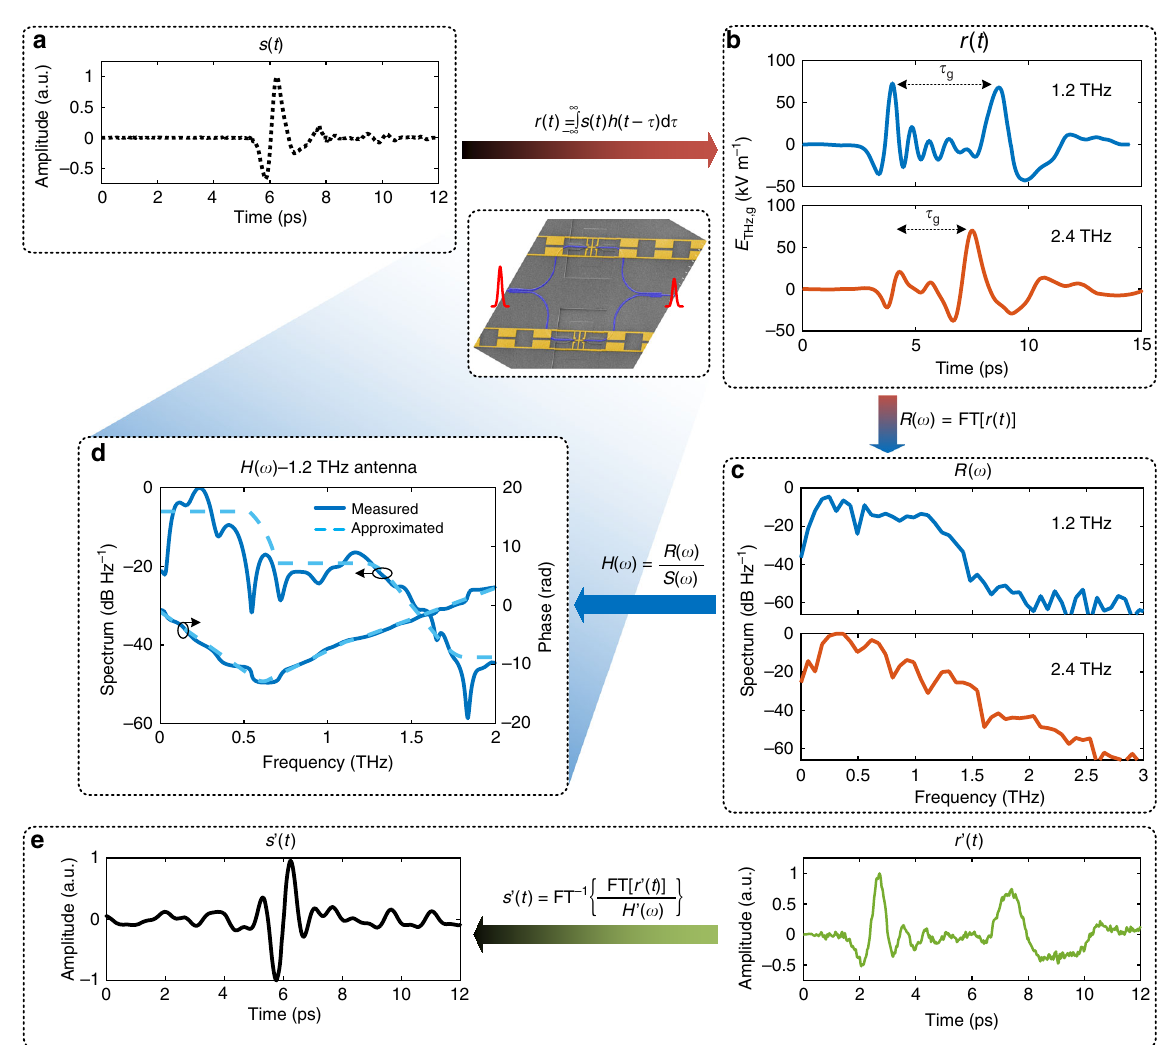
Fig. 3 Experimental results. a Time domain signal of the PCA source measured with a 200 μ m ZnTe crystal. b Electric fi eld amplitude of the THz pulse in time domain detected by the MZI detectors with center frequencies of 1.2 and 2.4 THz, respectively. In both cases, the initial pulse of the detected time trace is attributed to the response of the HF-THz antenna component. The following slow THz pulse originates from the response of the LF antenna component. The detected signal is the convolution of the source s ( t ) with the impulse response of the detector h ( t ). c The Fourier transform (FT) of the THz time traces for the 1.2 and 2.4 THz detector, respectively. In both cases, the dynamic range is ≥ 60 dB for an integration time of 20 s per point with an optical probe power of 63 nW. d Measured (solid blue lines) and approximated (dashed light blue lines) complex frequency response of the detector. The frequency response of the detector can be computed from the measured spectrum in c and the spectrum of the known source in a . e Example of a retrieved input signal (black curve) as derived from a measured time trace (green curve) using the approximated frequency response in d